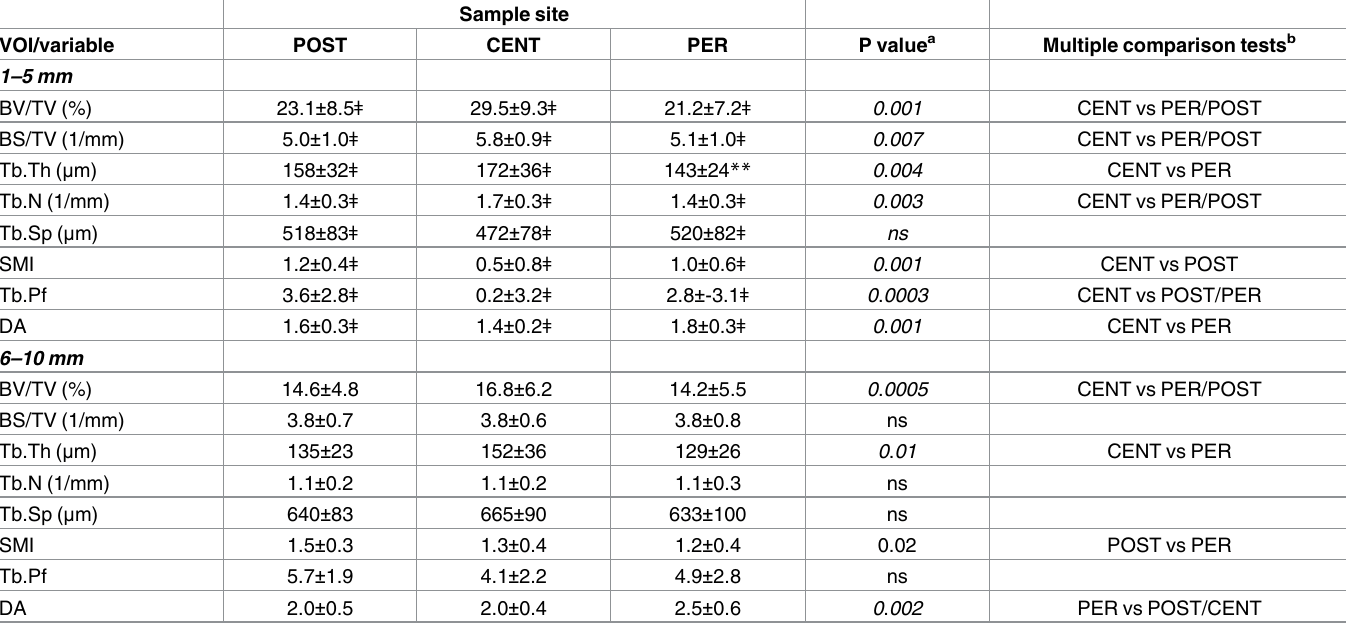
Table 4. Micro-architectural changes of the STB by sample site and depth for all knees (n = 28). Sample